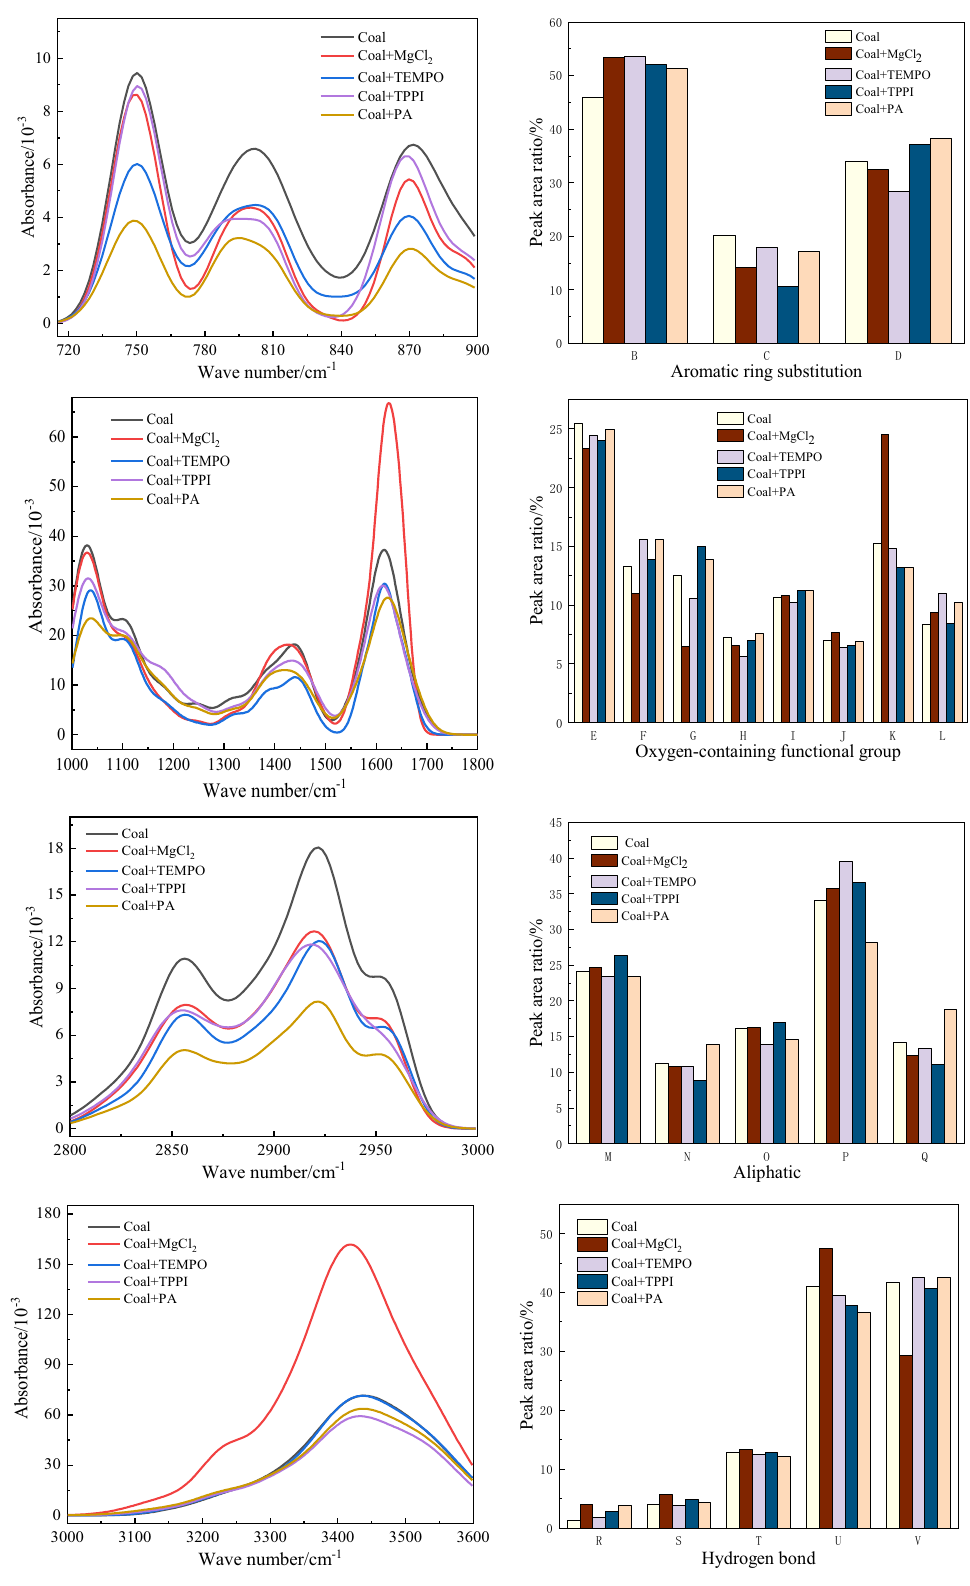
Figure 7. Fitting results of infrared spectral peaks and functional group peak areas of water-immersed coking coal after adding